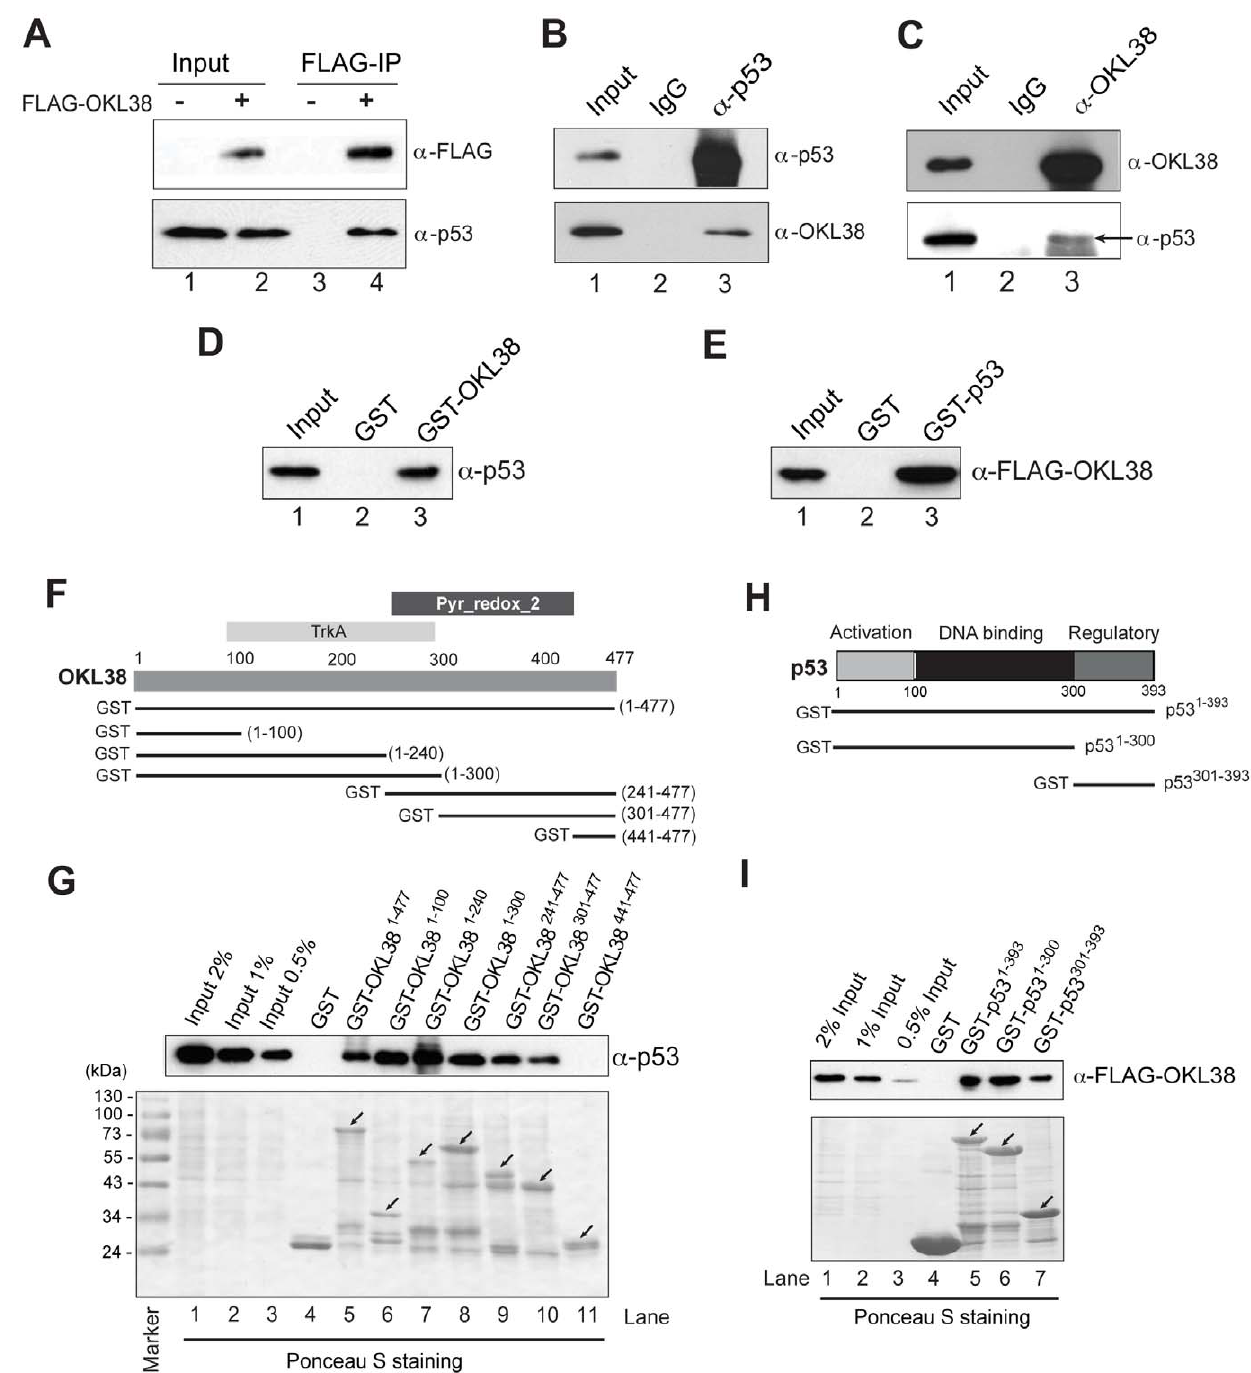
Figure 3. Interaction of OKL38 and p53 proteins. (A) p53 was co-immunoprecipitated by the M2 agarose beads together with the FLAG-OKL38 expressed in p53 + / + HCT116 cells, but not from the control cells without FLAG-OKL38 expression. (B) Nuclear extracts of U2OS cells were precipitated with normal mouse IgG or anti-p53 antibody and blotted with anti-p53 and anti-OKL38 antibodies. (C) Nuclear extracts of U2OS cells were precipitated with normal rabbit IgG or anti-OKL38 antibody and blotted with the anti-OKL38 and anti-p53 antibodies. Arrow denotes the position of p53. (D) GST-pull down experiments showed that GST-OKL38 beads retained p53 from nuclear extracts. (E) Similarly, GST-p53 beads retained FLAG- OKL38 expressed in Hela cells. (F) Illustration of OKL38 domain structures (TrkA and Pyr_Redox_2 domains) and the GST-truncation OKL38 constructs used to analyze OKL38 and p53 interaction. (G) Interaction of p53 with GST-OKL38 full length (residues 1–477) or its truncation derivatives in GST-pull down assays. Different percentages of input were loaded to serve as a control. (H) Illustration of p53 domain structures and its derivatives used in studying p53 and OKL38 interaction. (I) GST-pull down assays to detect interaction of FLAG-OKL38 with GST-p53 and its truncation derivatives.